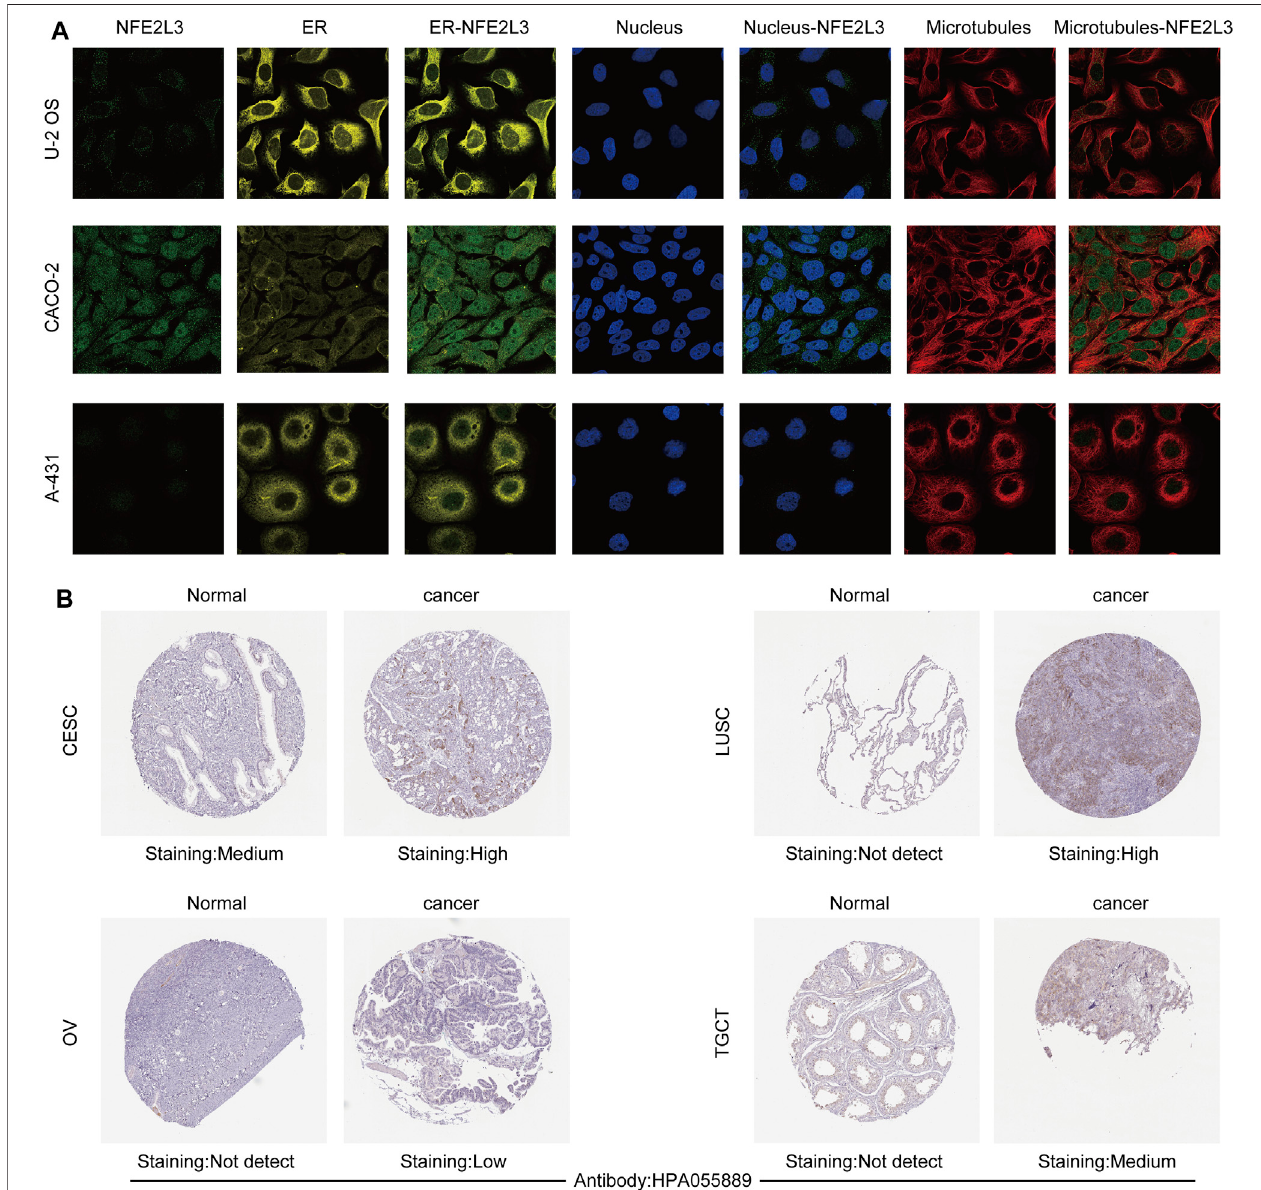
FIGURE 2 | Subcellular localization and immunohistochemical analysis of NFE2L3. (A) NFE2L3 was mainly located in the nucleoplasm and vesicles by immuno fl uorescence (ICC-IF) and confocal microscopy. (B) The expression levels of NFE2L3 protein in four tumors and normal tissues were analyzed by immunohistochemistry. The results were all obtained from the HPA